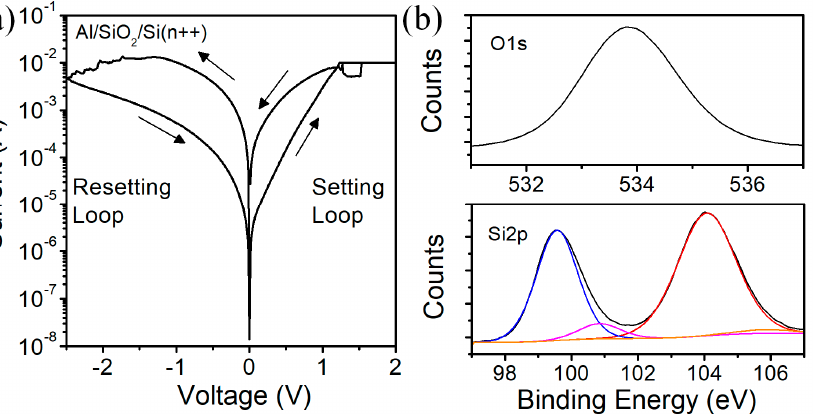
Figure 2. Typical I-V characteristics of a fresh Al/SiO 2 /n++-Si RRAM device measured at 25 °C ( a ) and XPS spectra ( b ) for silicon oxide used as a resistive switching layer.